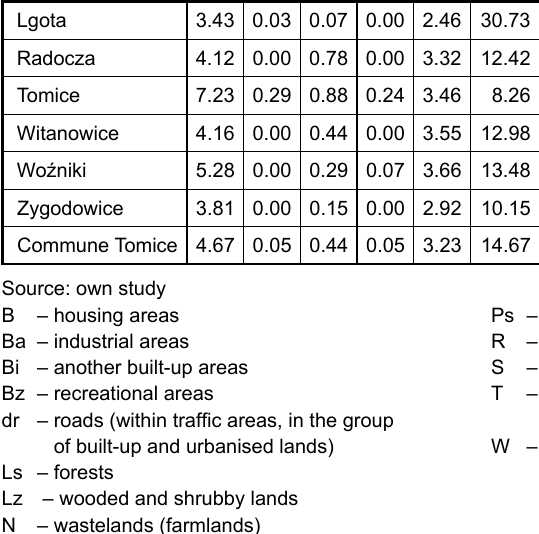
Table 3. Percentage of groups and types of land use in the total area of each village in the commune of Tomice Groups and kinds of land properties (% of village’s general Village’s name